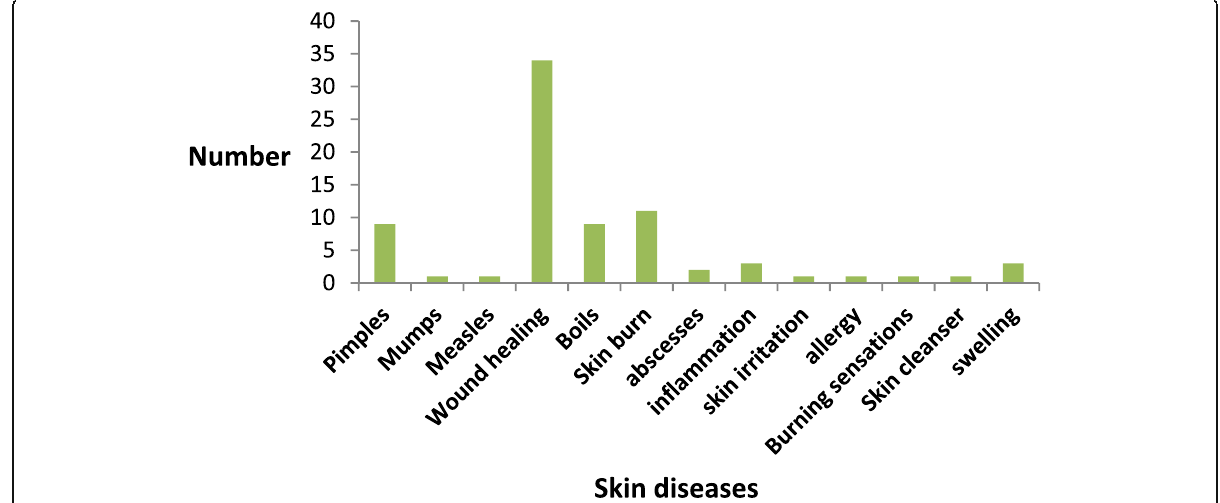
Fig. 5 Categories diseases of medicinal plants used for skin disorders in Northern